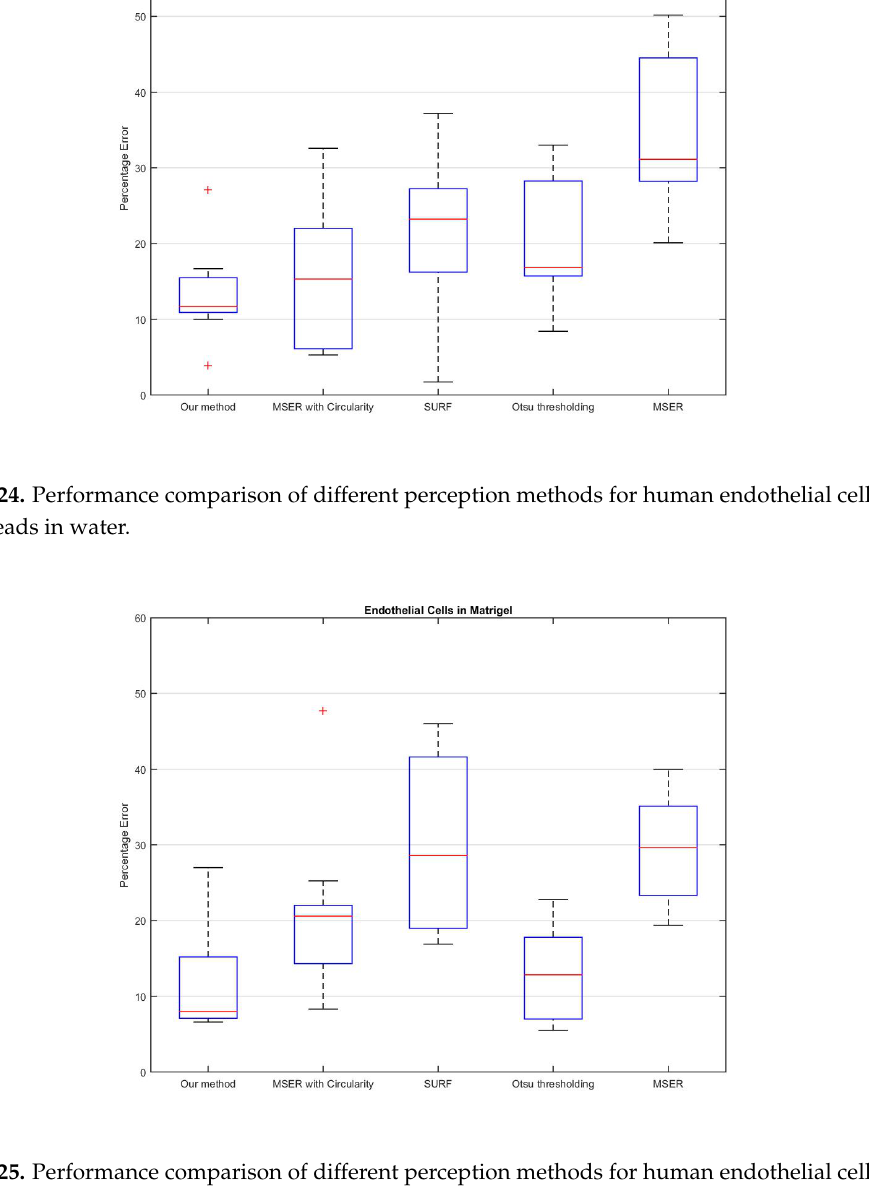
Figure 25. Performance comparison of different perception methods for human endothelial cells and silica beads in